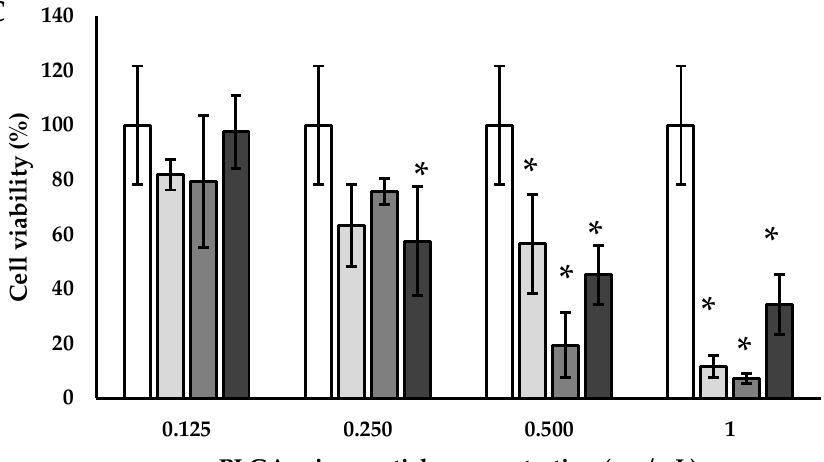
Figure 8. Cell viability of endothelial cells grown for ( A ) 24, ( B ) 48, and ( C ) 72 h in the presence of PLGA MPs, * p < 0.05 (with respect to the control using ANOVA with Tukey’s HSD post hoc multiple comparison test). PLGA: poly(lactic- co -glycolic acid).